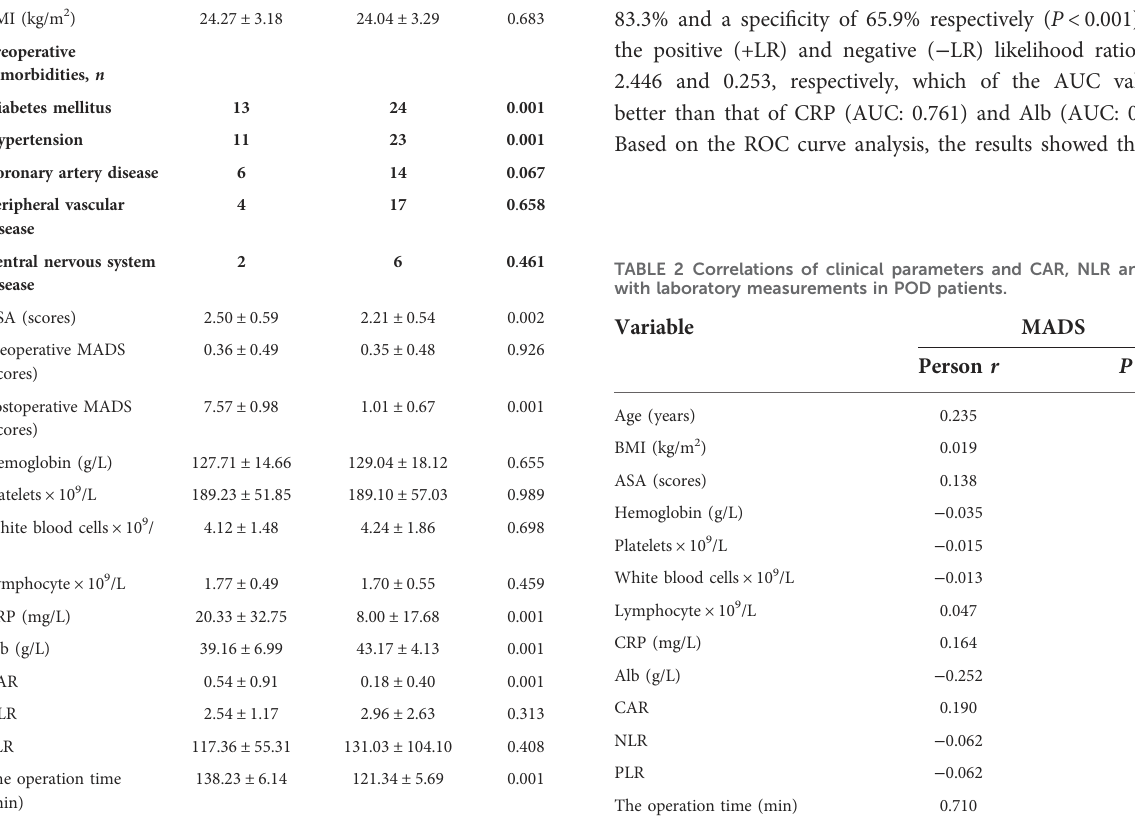
evaluated by ROC curve analysis. As shown in Table 3 and Figure 3 , the area under the curve (AUC) of CAR for POD was 0.782, with the cut-off value of 0.117, a sensitivity of 83.3% and a speci fi city of 65.9% respectively ( P < 0.001), and